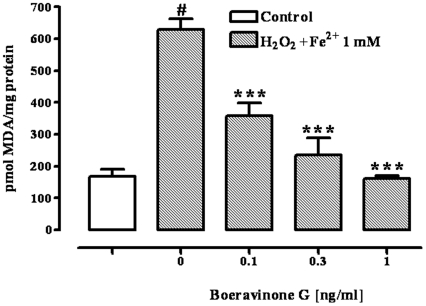
Effect of boeravinone G (0.1–1 ng/ml) on Fenton's reagent (H2O2/Fe2+ 1 mM)-induced malondialdehyde-equivalents (MDA-equivalents) production.Effect observed in differentiated Caco-2 cells after 24-hour boeravinone G exposure. Data represent mean ± SEM of 6 experiments. #p<0.001 vs control (vehicle) and ***p<0.001 vs H2O2/Fe2+ alone.